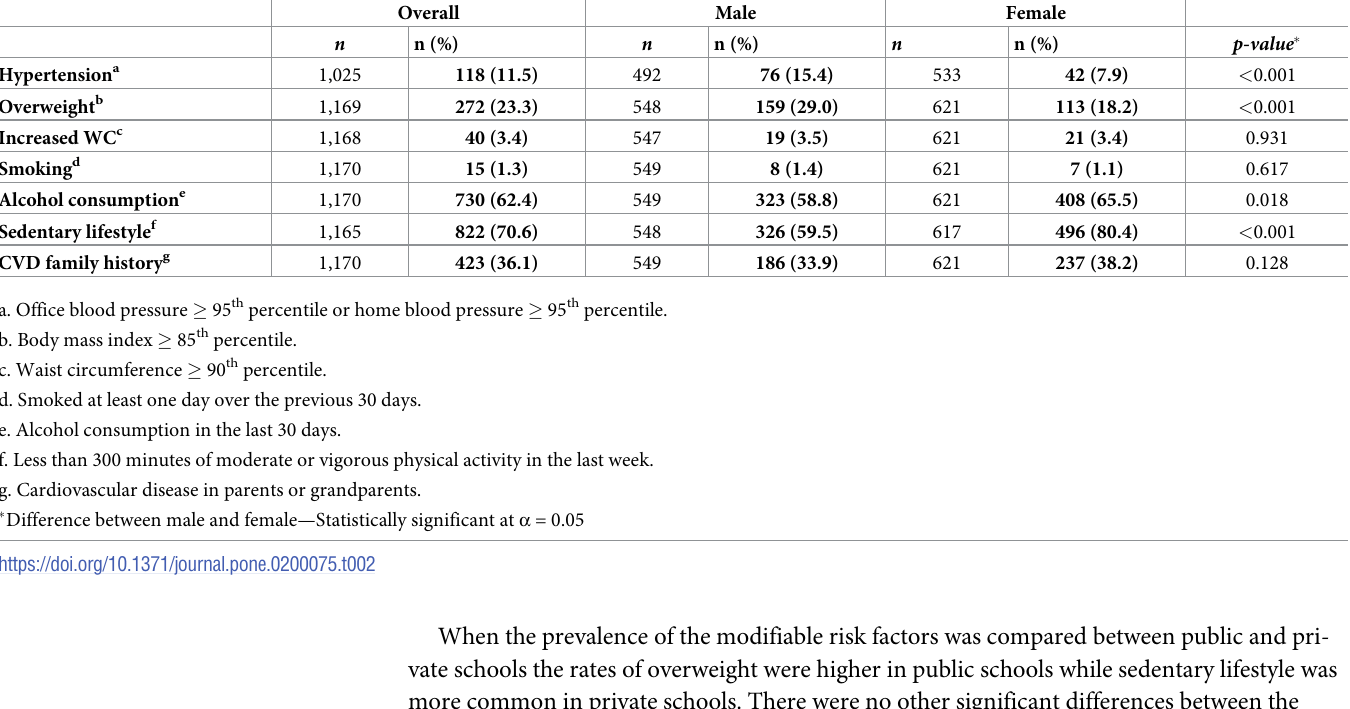
When the prevalence of the modifiable risk factors was compared between public and pri- vate schools the rates of overweight were higher in public schools while sedentary lifestyle was more common in private schools. There were no other significant differences between the groups with regards to the remaining modifiable risk factors, as shown in Table 3. Most adolescents had at least two risk factors (68.9%) and more than ten percent had more than 4 risk factors. In only 6.7% of the sample no cardiovascular risk factor was identified (Fig 1). Family history of CVD, increasing age, and being enrolled in private schools were directly associated with the number of modifiable CV risk factors, as shown in Table 4.